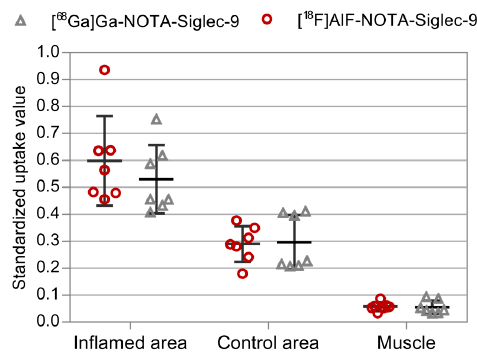
Figure 5. Inflamed area (skin/muscle from the right foreleg, control area (skin from the left foreleg), and healthy muscle (hind leg) SUVs (ex vivo, 60 min after injection, n = 7 ).